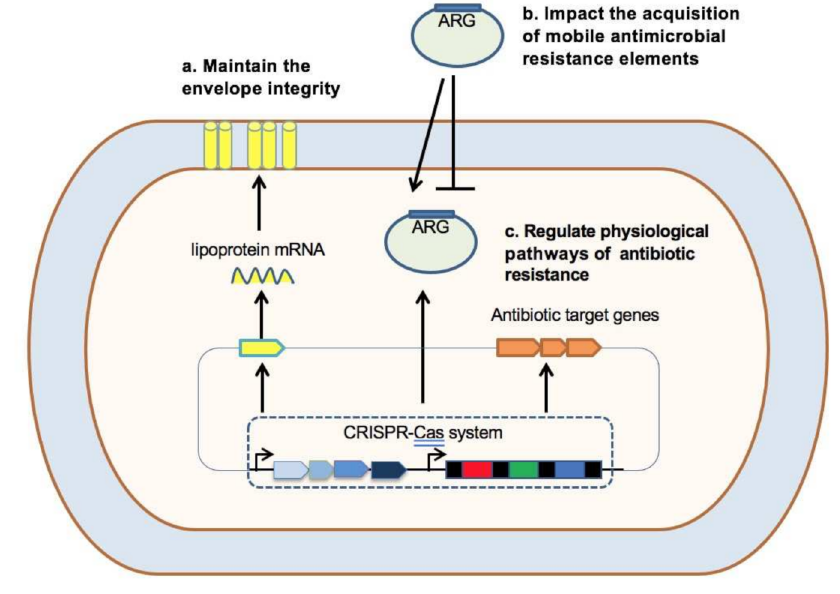
Figure 2. Relationships between the CRISPR-Cas system and antibiotic resistance in bacteria. a. The CRISPR-Cas system can maintain envelope integrity by regulating envelope lipoprotein expression to enhance antibiotic resistance, such as in Francisella novicida . b. The CRISPR-Cas system can impact the acquisition of mobile antimicrobial resistance elements to avoid antibiotic resistance, such as in Campylobacter jejuni and Enterococcus faecalis . c. The CRISPR-Cas system can regulate the physiological pathway involved in the antimicrobial resistance of bacteria, such as in Klebsiella pneumoniae . ARG: antibiotic resistance